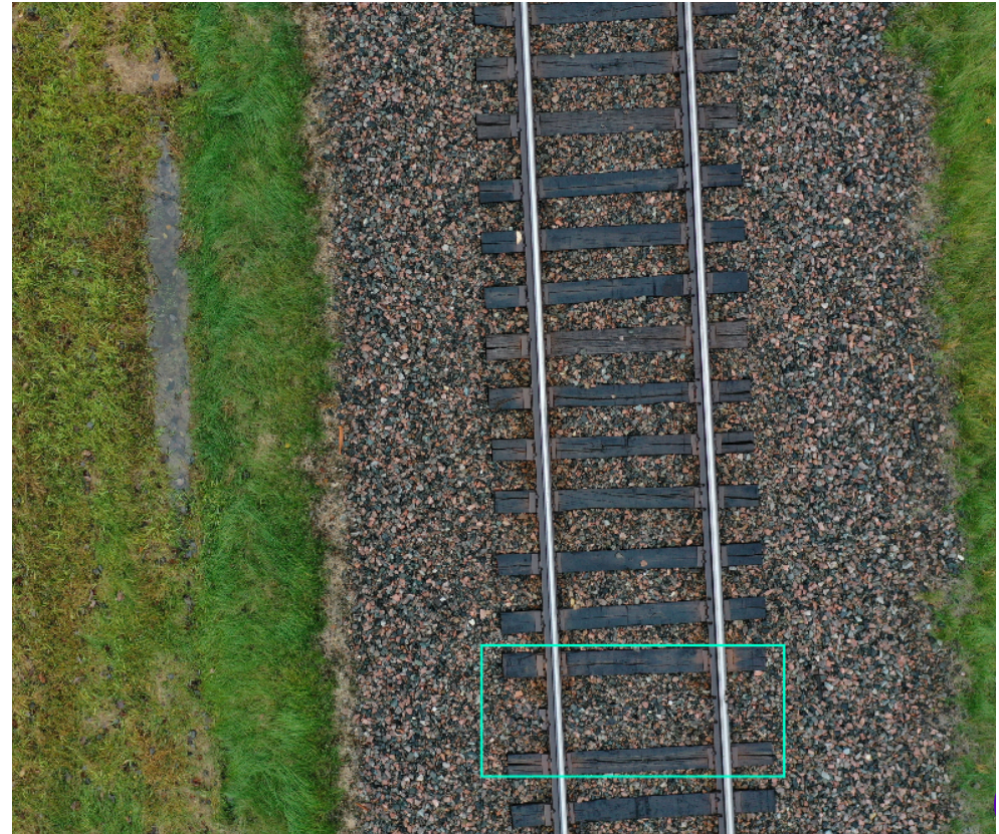
Figure 7. Example of a missing tie. Broken Tie: If there was a crack at least 50% of the length of the tie (calculated horizontally), the tie was annotated as a broken one. An example is shown in Figure 8.